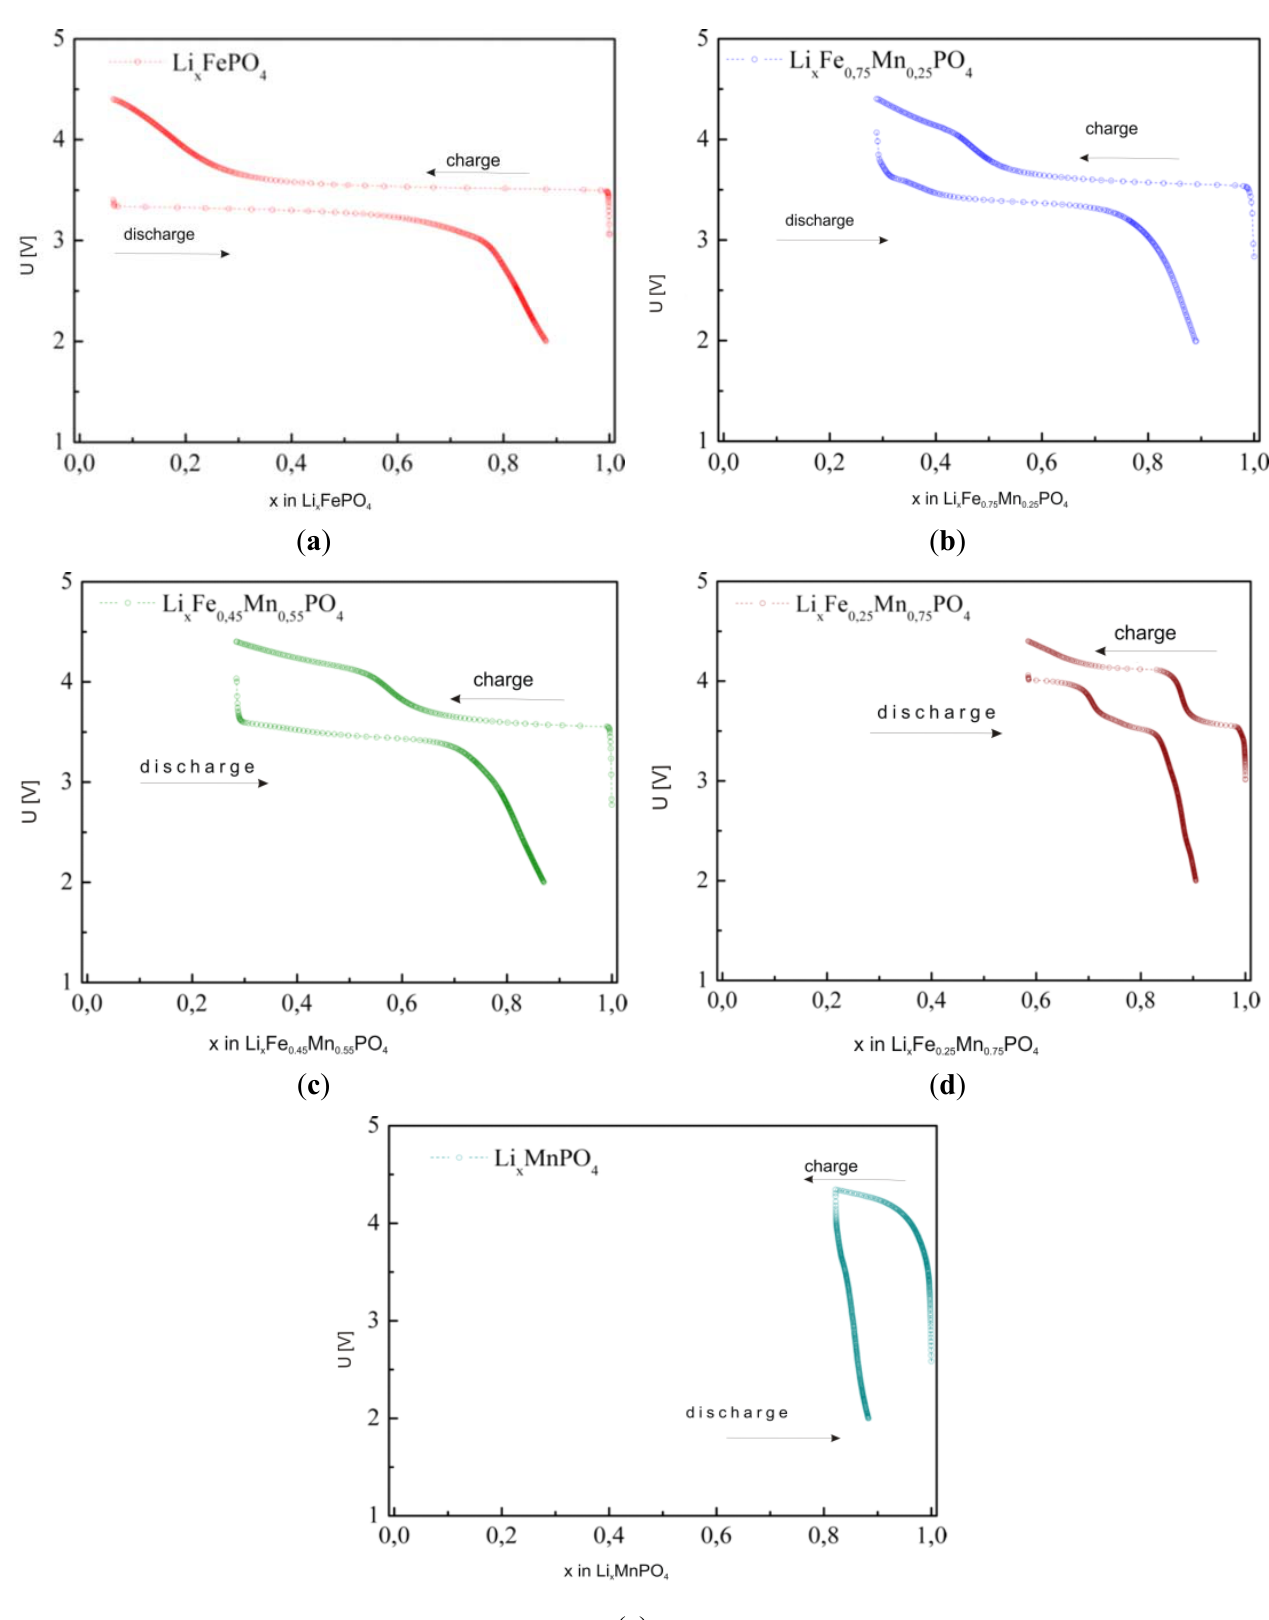
Figure 29. Charge/discharge curves for Li/Li + /Li rate for materials with: ( a ) y = 0; ( b ) y = 0.25; ( c ) y = 0.55; ( d ) y = 0.75 and ( e ) y = 1